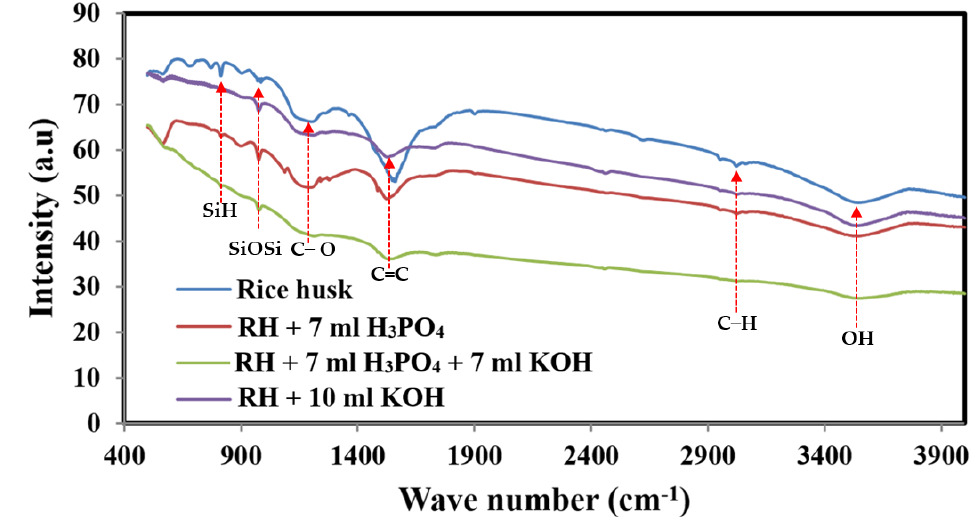
Figure 1. FTIR spectra of prepared sample RH, RH + 7 mL H 3 PO 4 , RH + 10 mL KOH and RH + 7 mL H 3 PO 4 :7 mL KOH.